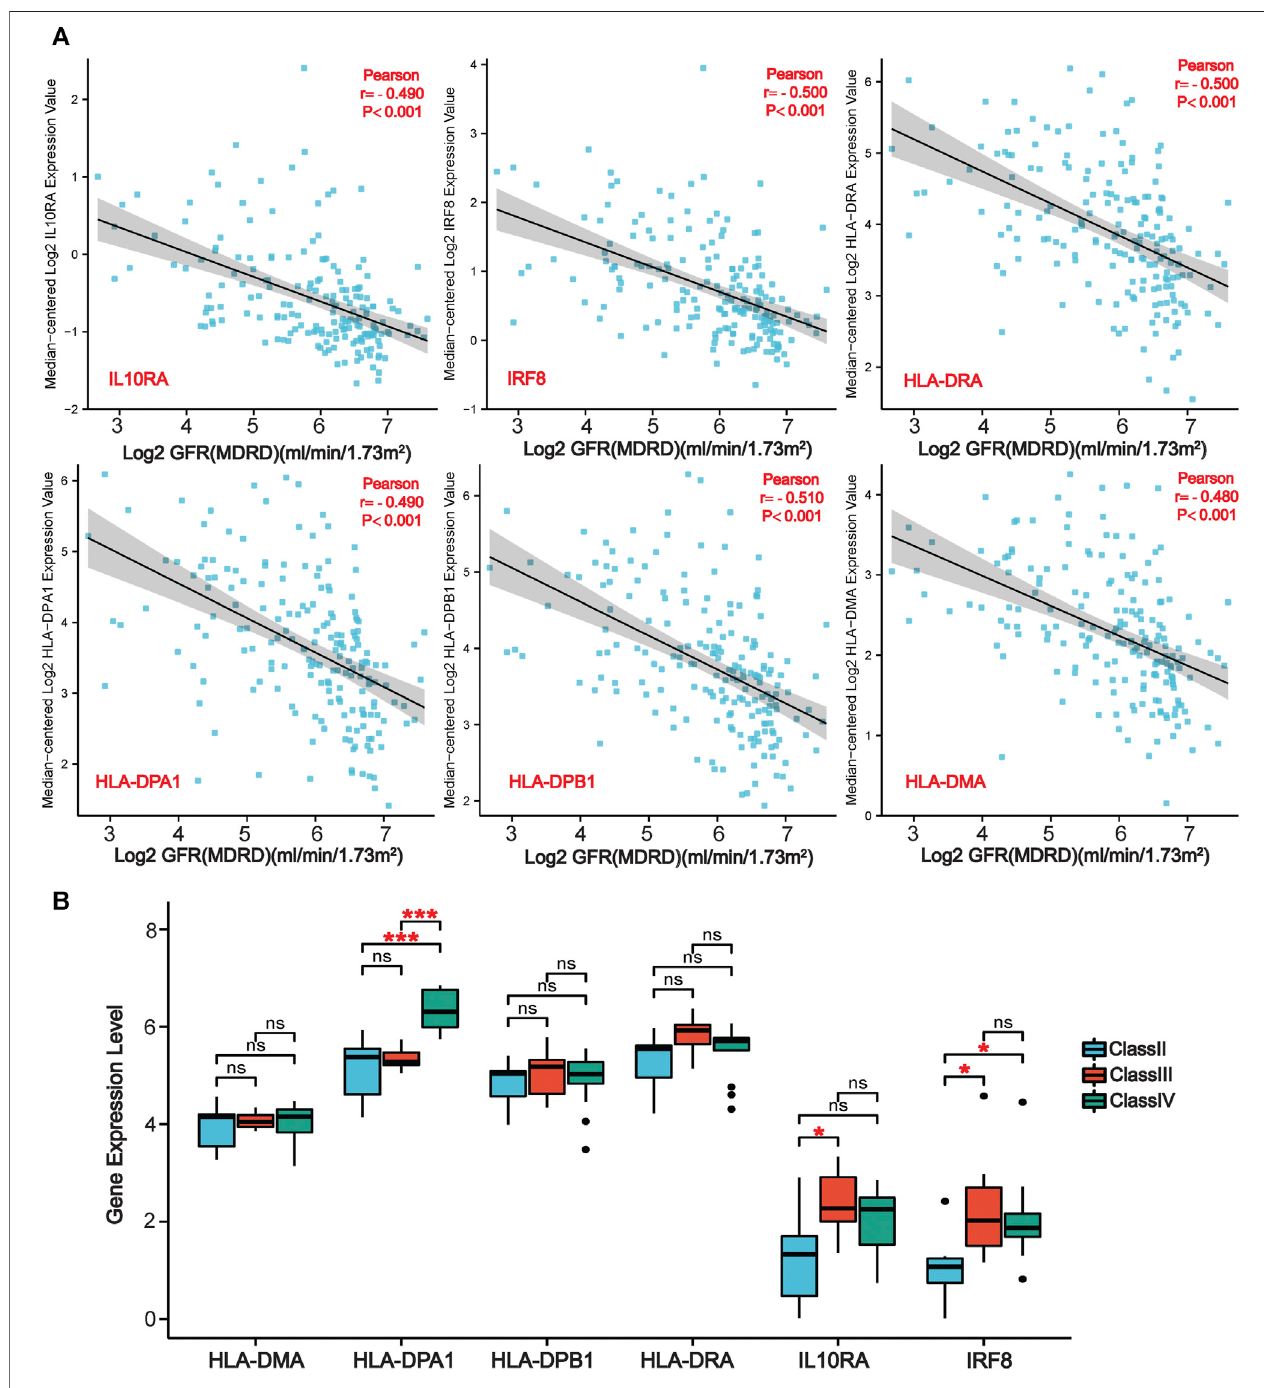
FIGURE 7 | | Association of co-DEGs with LN clinical traits in the Nephroseq database. (A) Correlation analysis of six co-DEGs with the glomerular fi ltration rate of patients (GFR). (B) Variations of six co-DEGs in samples from patients with different pathological staging of lupus nephritis. (* p < 0.05, *** p < 0.001).